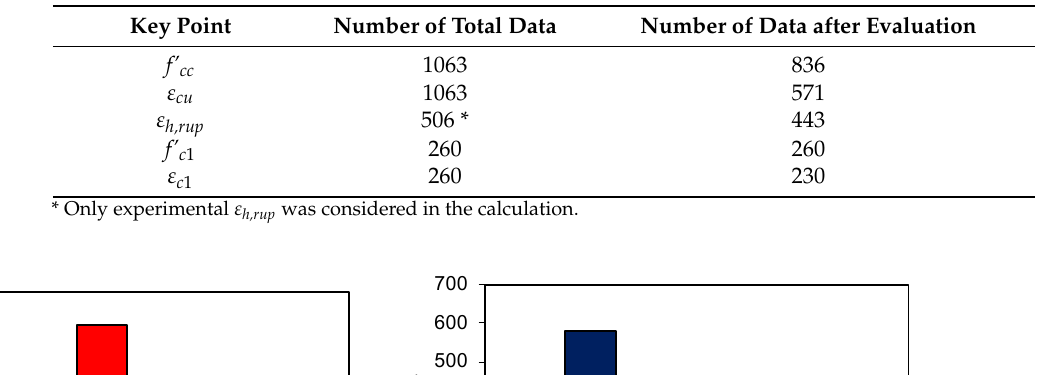
Table 1. Summary of test results in the database.